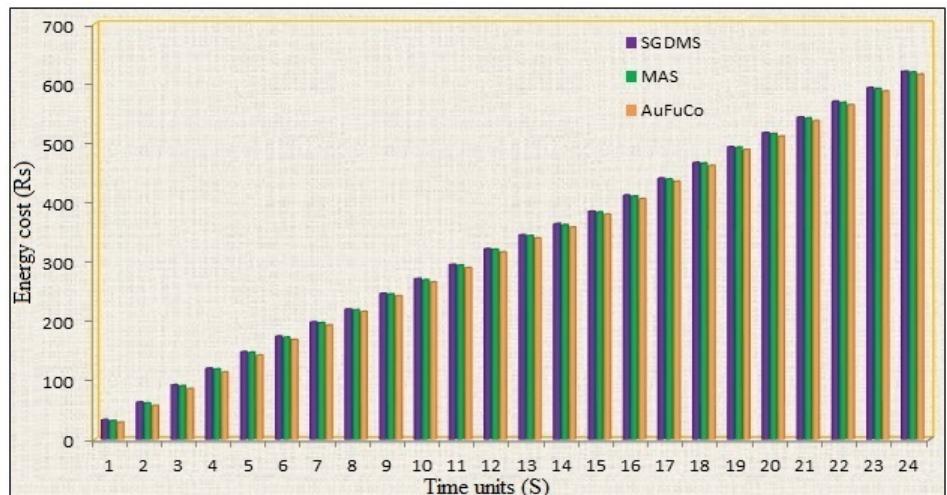
Figure 26. Comparison of energy cost variation by 2030 (for present energy consideration).